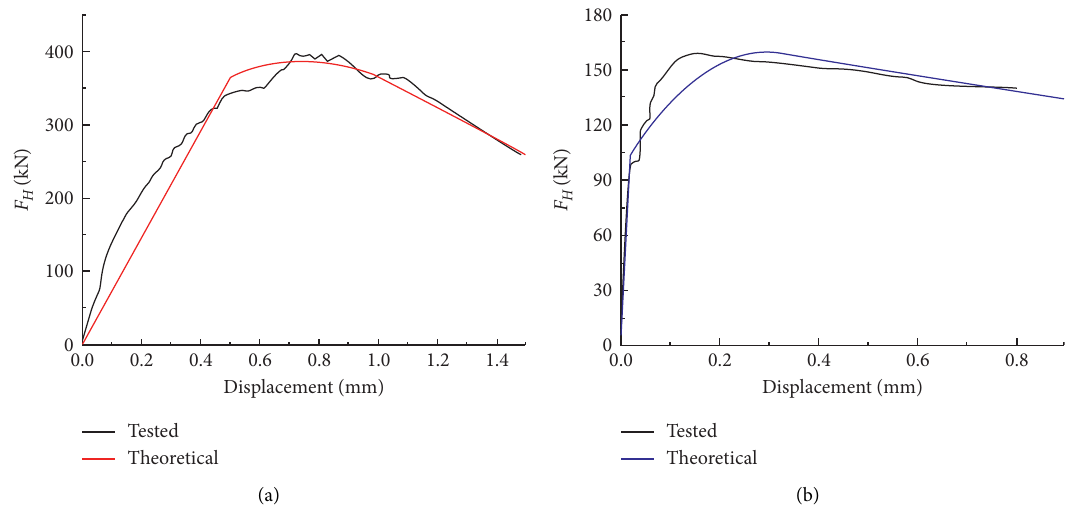
Figure 5: Comparison of force-displacement relationships constructed by the proposed method and full-scale test. (a) Max B¨ogl company; (b)